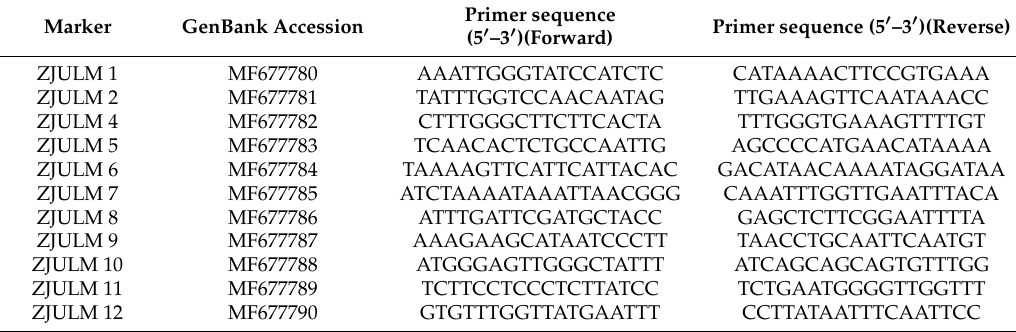
Table 6. Genomic SSR markers